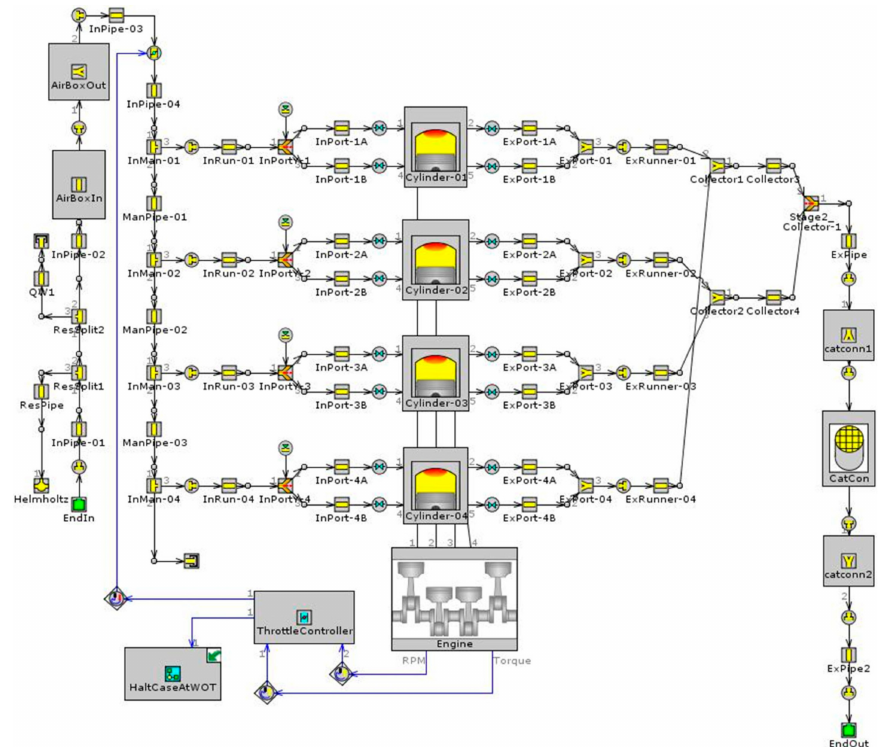
Figure 14. Four-Cylinder SI (Spark Ignition) Engine Model in